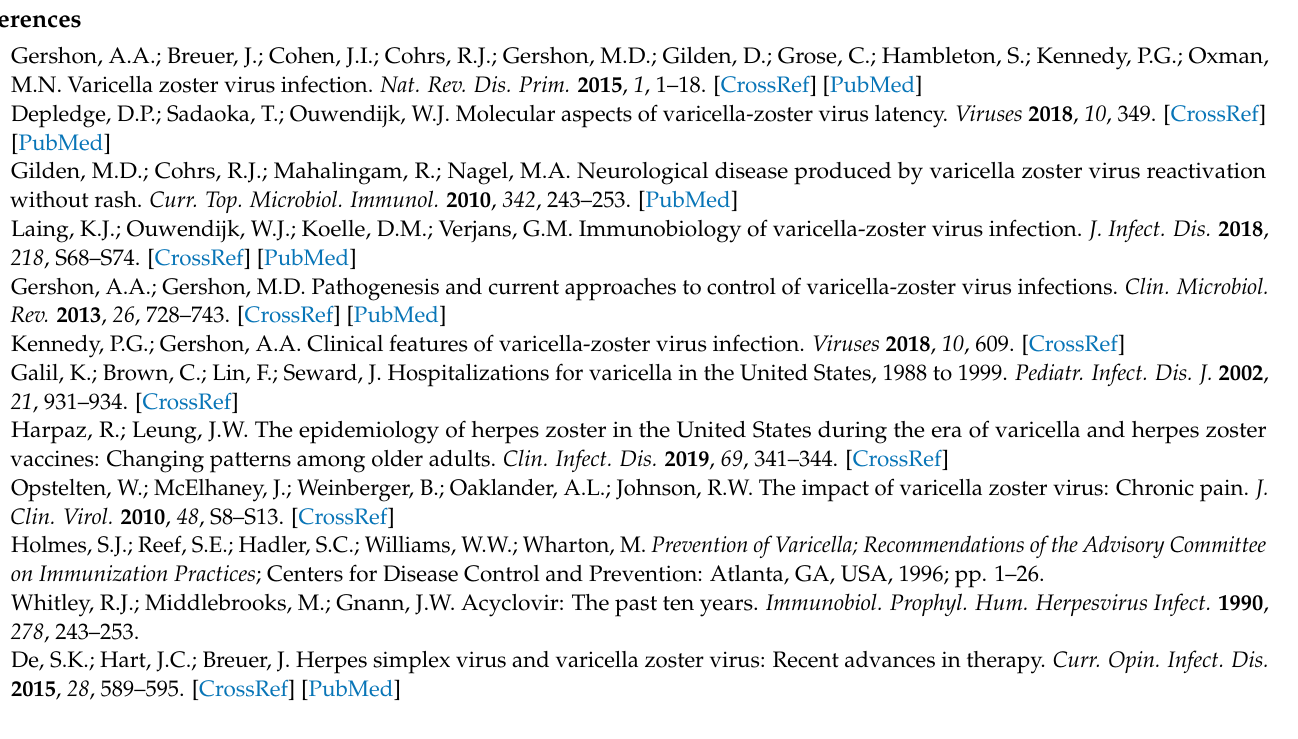
Figure S2: Effects of kaempferol on VZV lytic gene